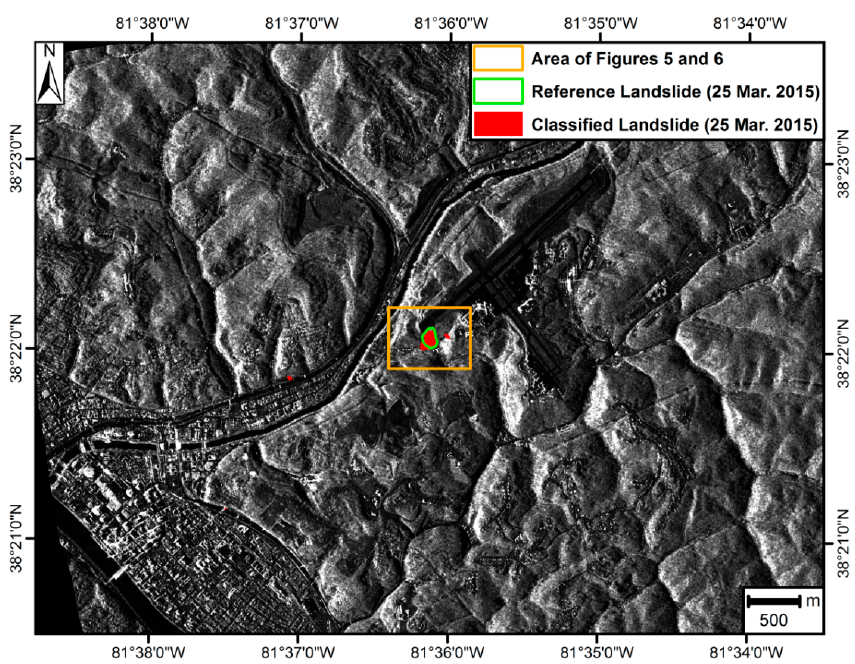
to refine the reference polygon of the landslide.